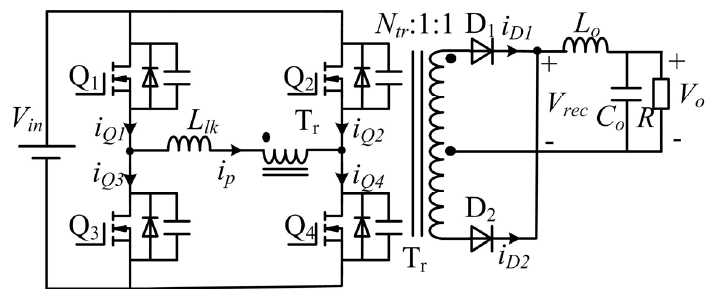
Figure 1. Circuit diagram of a PSFB converter.